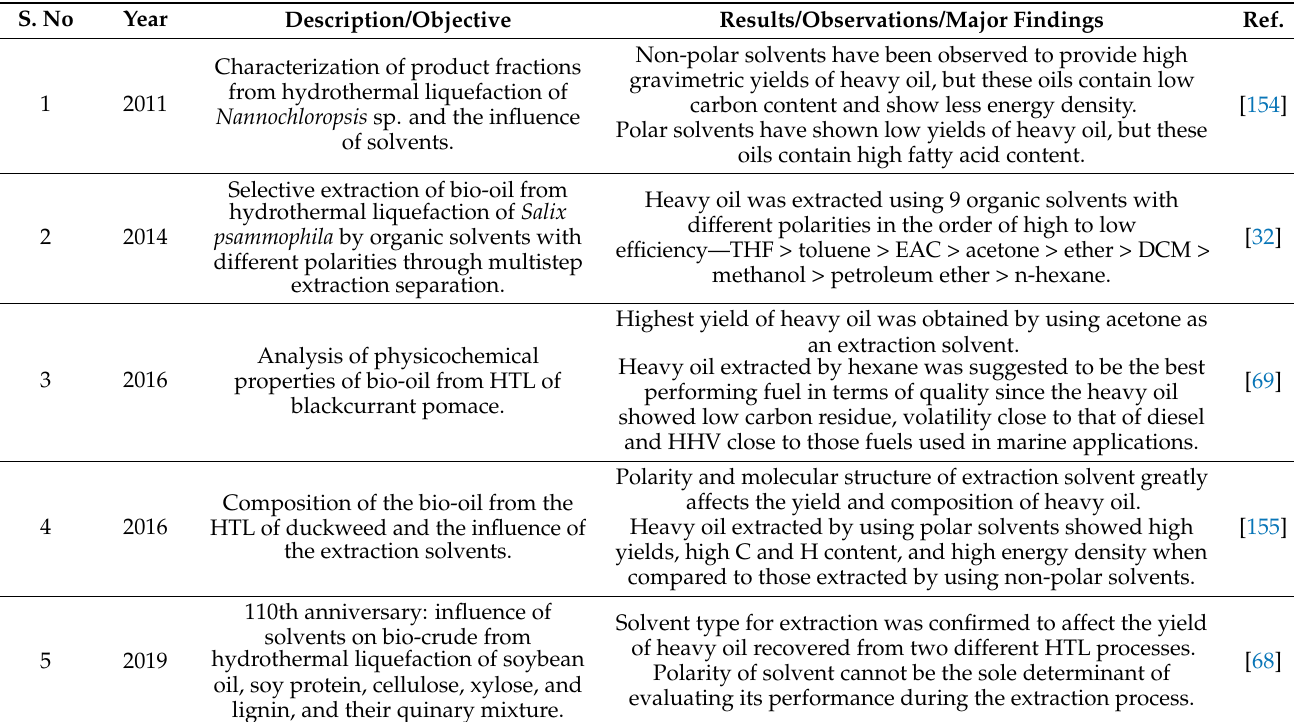
Table 12. Studies on effect of extractive solvent in HTL